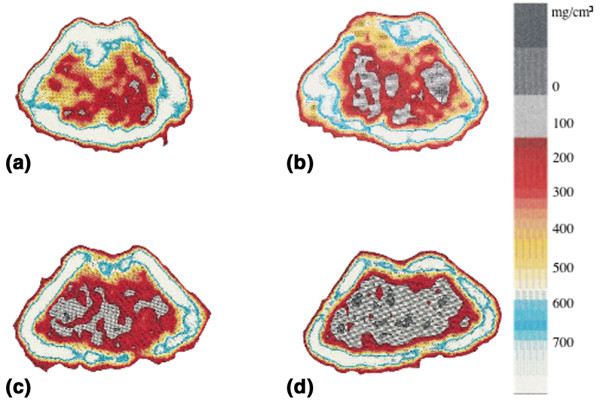
Peripheral quantitative computed tomography (pQCT) scans of one representative mouse in each group. Trabecular bone mineral density (BMD) was determined with a metaphyseal scan at a point 3% of the length of the femur from the growth plate and the inner 45% of the area was defined as the trabecular bone compartment. (a) Sham-operated control; (b) ovariectomy control; (c) sham-operated, arthritic mouse; (d) ovariectomized, arthritic mouse. The bar shows the density of the bone, from 0 (black) to 750 mg/cm3 (white).